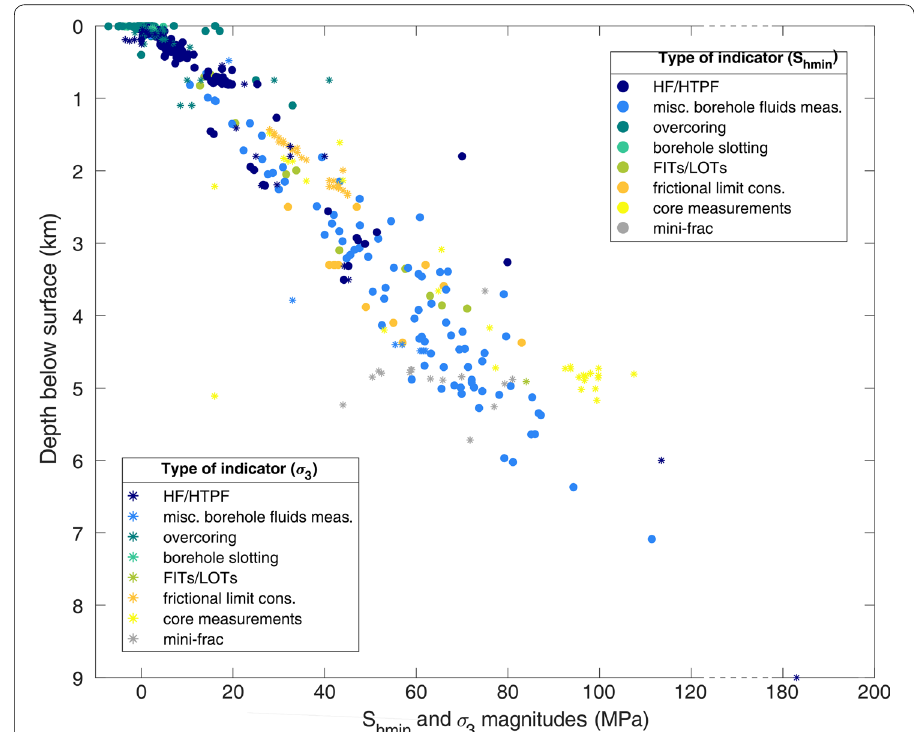
Fig. 7 Depth distribution of stress magnitude data. Minimum principal stress ( σ 3 ) magnitude and horizontal stress ( S hmin ) magnitude, depending on how it is indicated in the reference, plotted with record depth below surface. Plotted are all data records for which the one and/or the other information is available, resulting in 530 data points ( n Shmin 379; n σ 3 151). 30 data records provide both S hmin and σ 3 magnitude, therefore = = 500 distinct records remain. The difference to the total number of data records in the database ( n results from the fact that some records provide only other types of stress information or lack the required depth information. The colour code in the plot corresponds to that used in Figs. 5a and